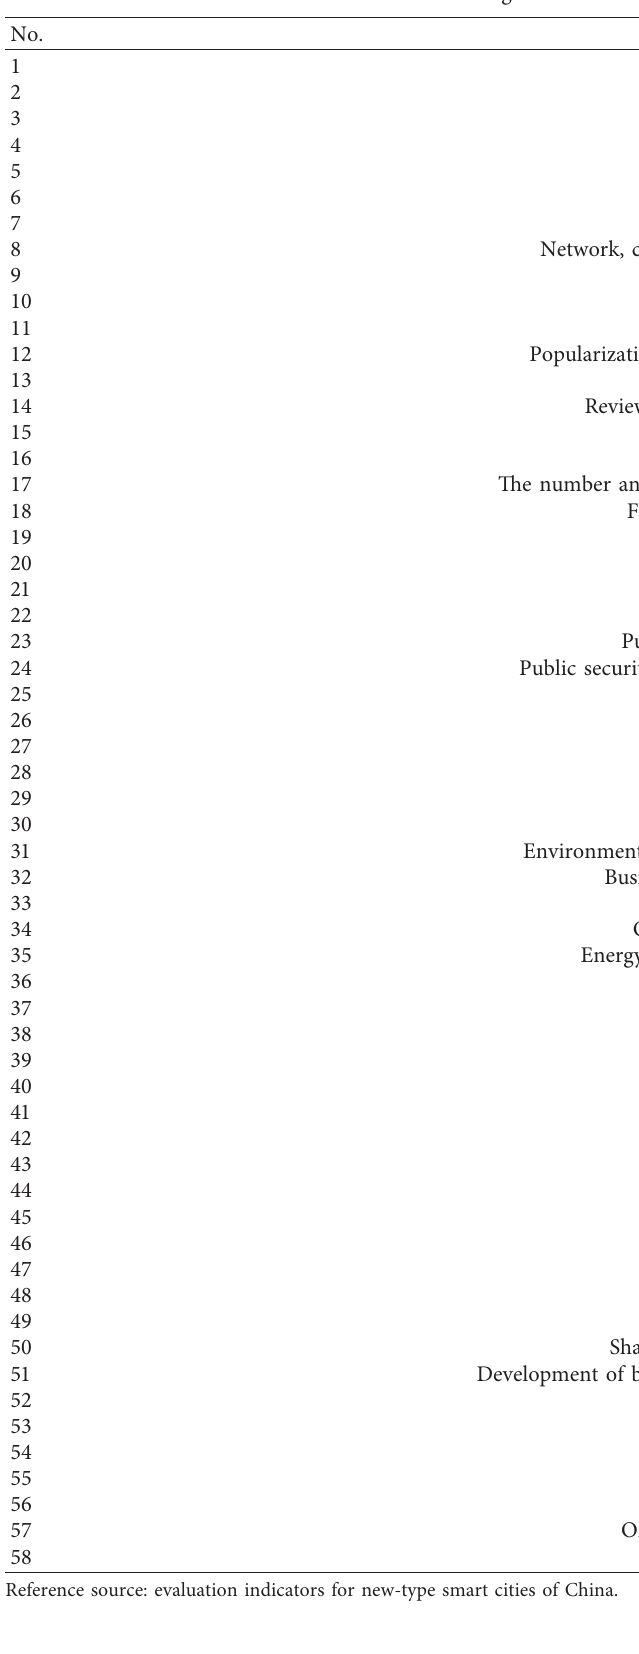
Table 1: The original evaluation indexes for the smart